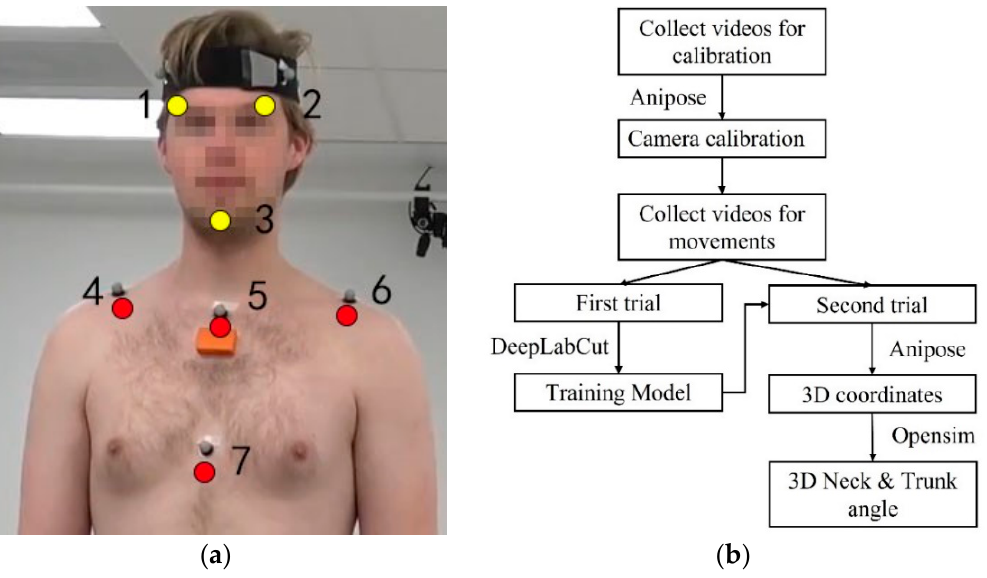
Figure 4. ( a ) Virtual tracking points of the markerless method; ( b ) Workflow of markerless method.